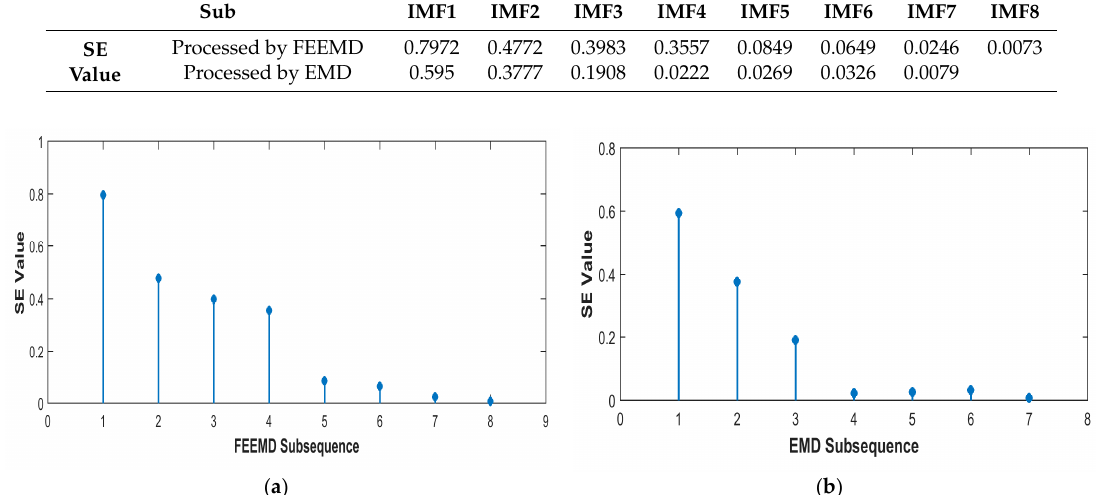
Table 1. The results on the sample entropy (SE) values.